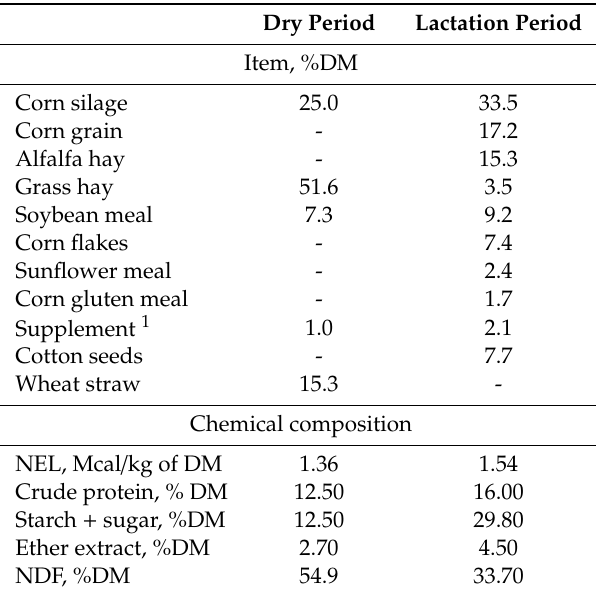
Table 1. Composition and characteristics on a daily basis of the experimental diets fed to cow during dry and lactation